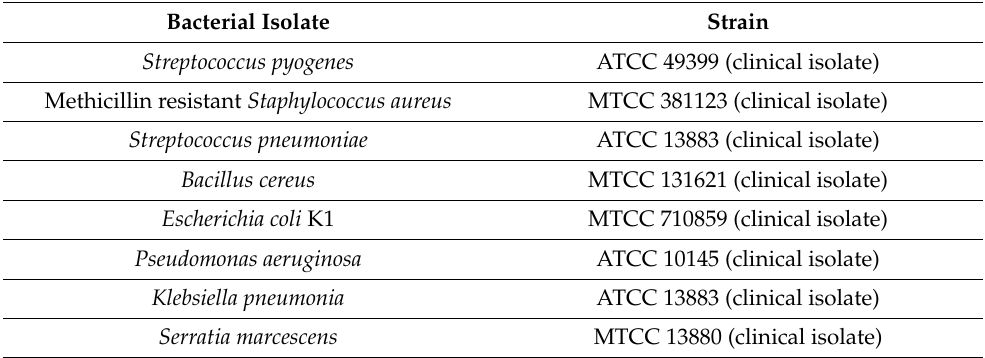
Table 1. Bacteria used in this study. Bacterial Isolate